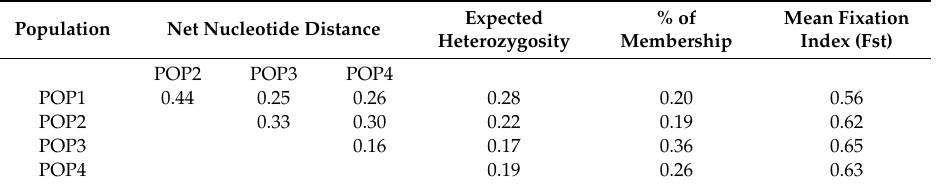
Table 2. Genetic divergence among (net nucleotide distance) and within (expected heterozygosity) population, proportion of membership, and mean value of Fst observed from the study of the population structure of 186 chickpea genotypes using DArTseq-SNP markers.